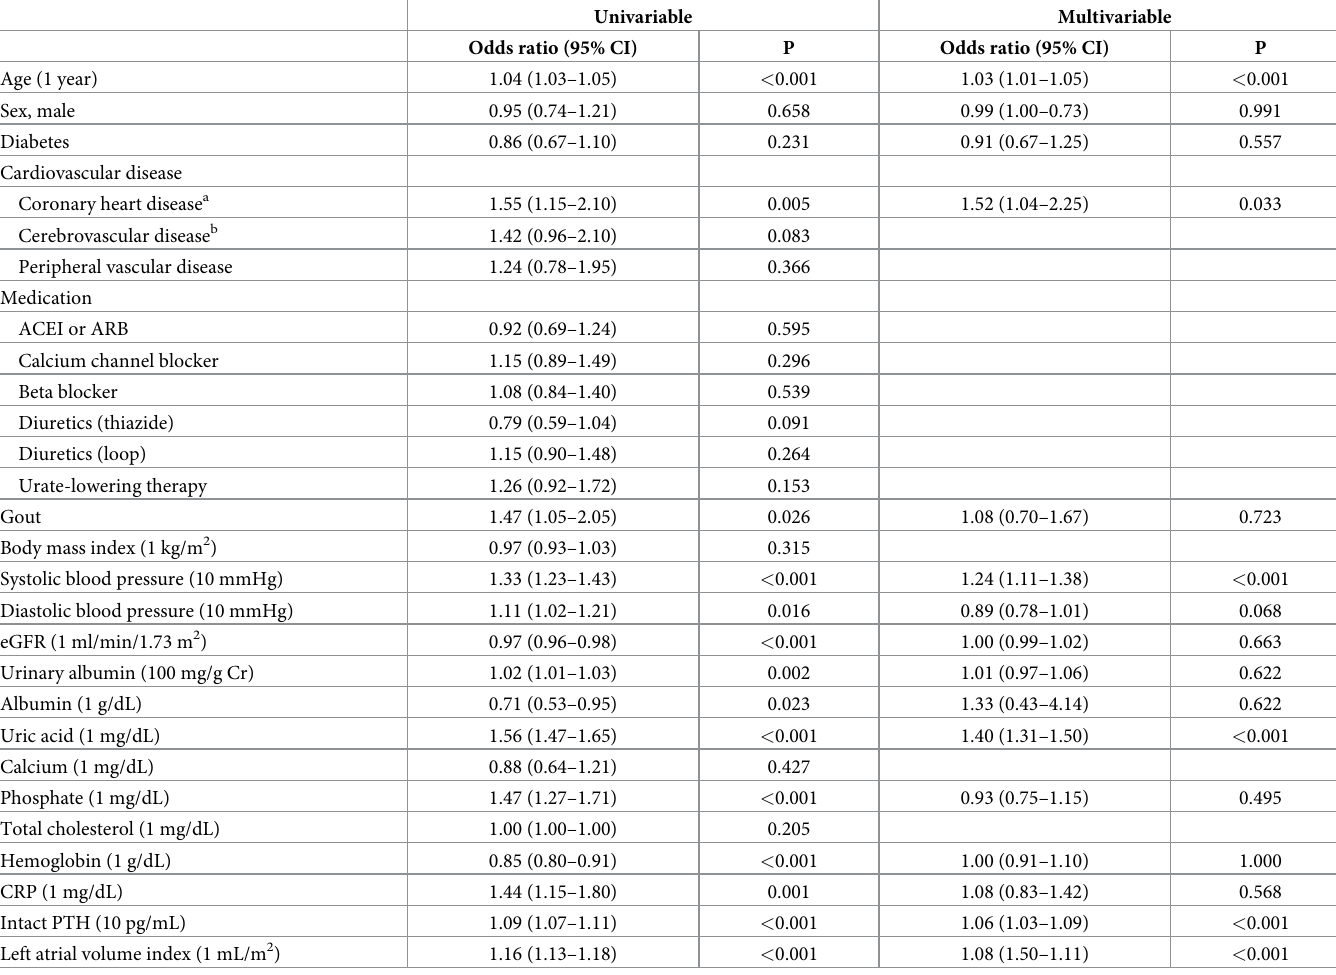
Table 4. Univariable and multivariable analyses for variables associated with LVH in study population (n =